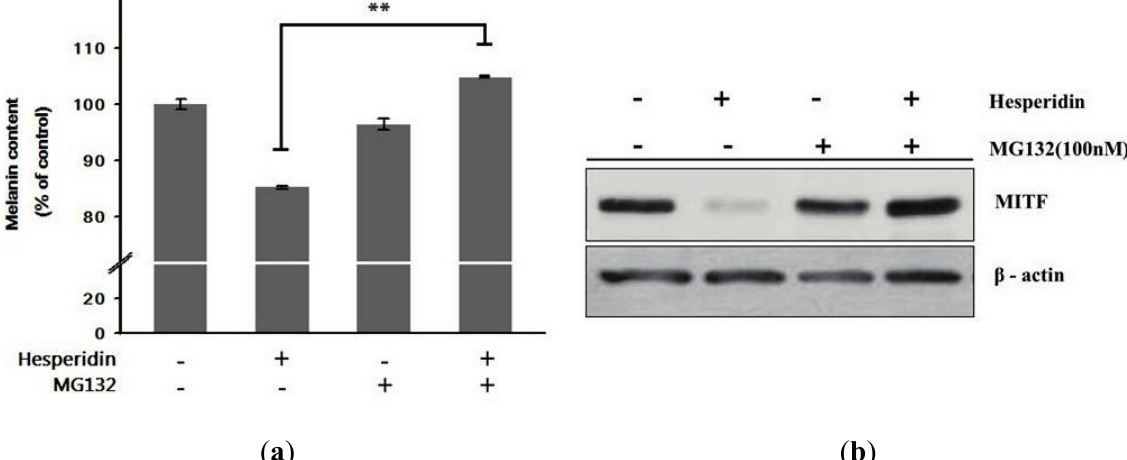
Figure 5. Effect of co-treatment with hesperidin and MG132 (protease inhibitor) on ( a ) melanin contents and ( b ) MITF protein expressions in B16F10 cells. Cells were incubated with MG132 with or without hesperidin. Melanogenesis-related protein expressions were analyzed by Western blot. Each percentage value for the treated cells was reported relative to that in α -MSH-stimulated cells. Data were expressed as mean ± SD of three independent experiments carried out in triplicates. ** p < 0.01 as compared to the one treated with hesperidin (30 μ M)